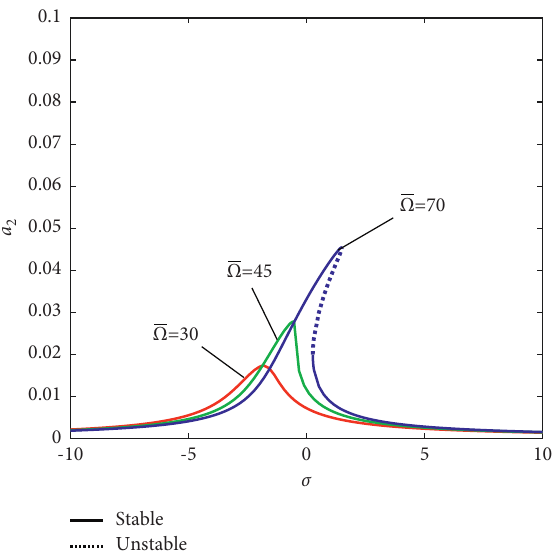
Figure 32: The effect of rotating speed on frequency response curve (L/d � 10, c � 0.01, case II).